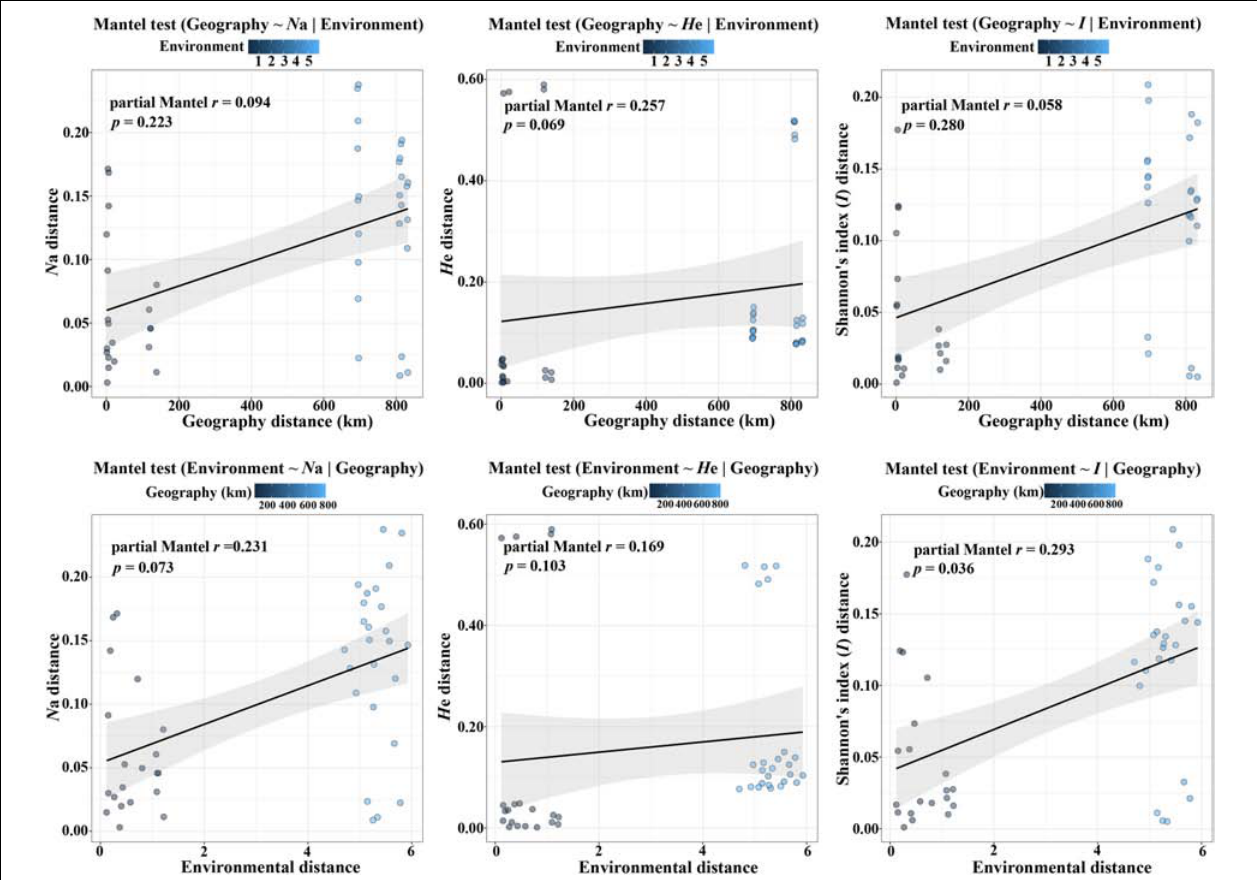
FIGURE 5 | Plot of partial Mantel tests for the correlation between genetic diversity parameter (Bray–Curtis distance) and explanatory distances (geographic and environmental distance) using Spearman’s coefficient.